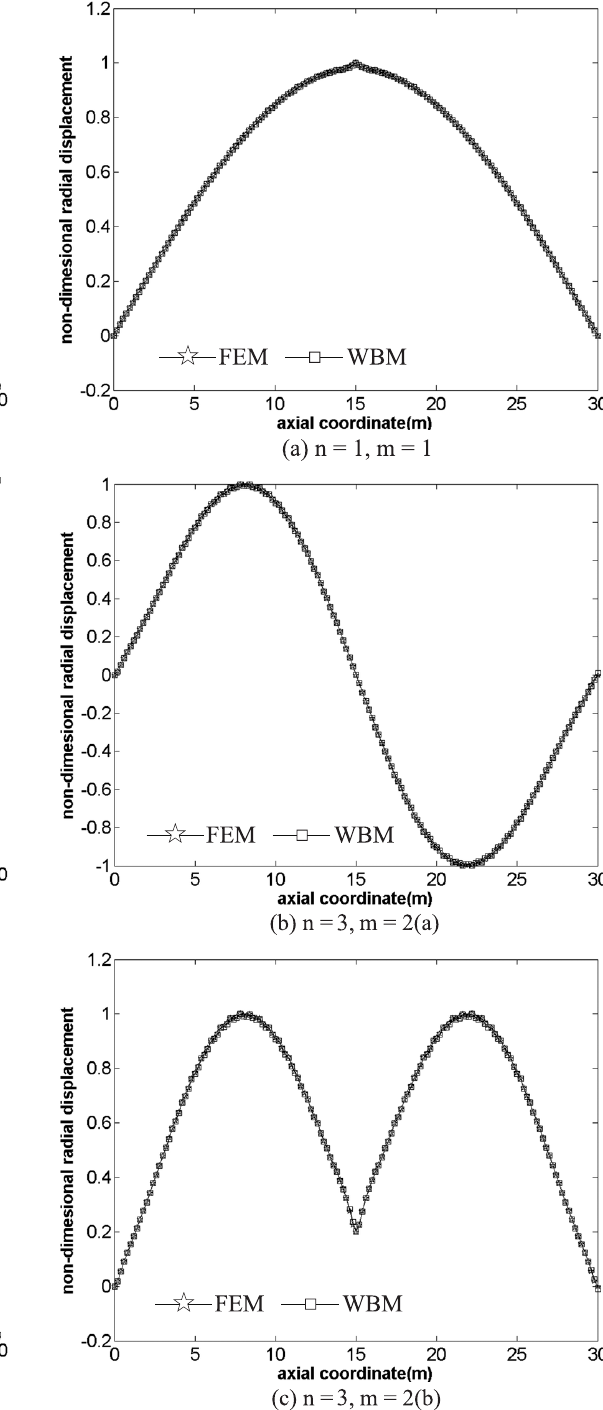
Fig. 9. Comparison of vibration mode shapes of model M1 calculated by FEM and WBM for F-F boundary condition.